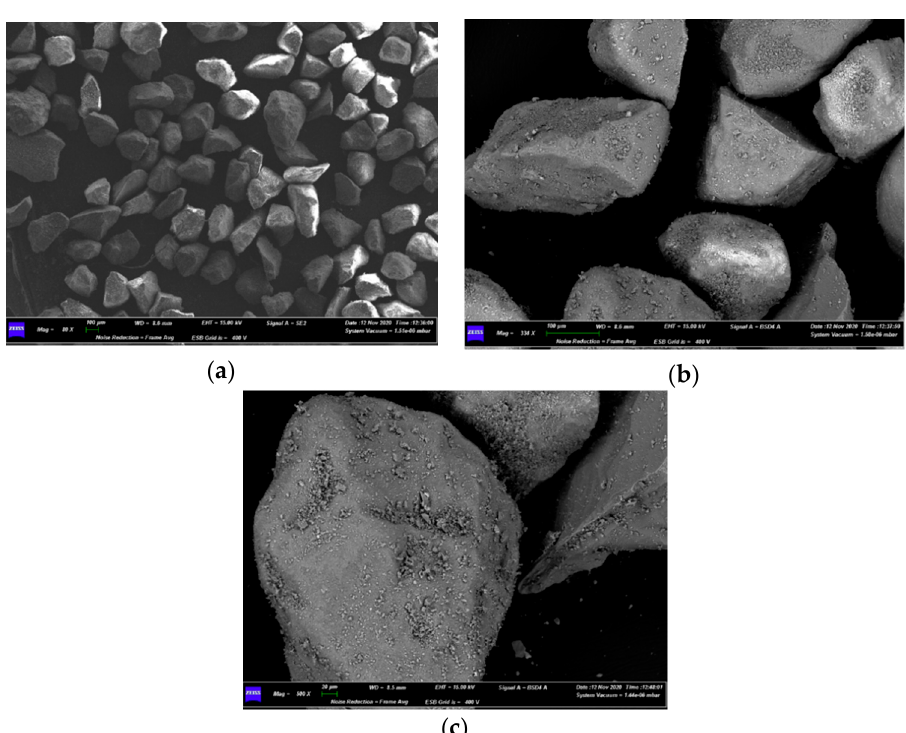
Figure 11. SEM micrographs of intermediate part of spent sand bed after the last test, magnified at: 80× ( a ); 336× ( b ); 500× ( c ).